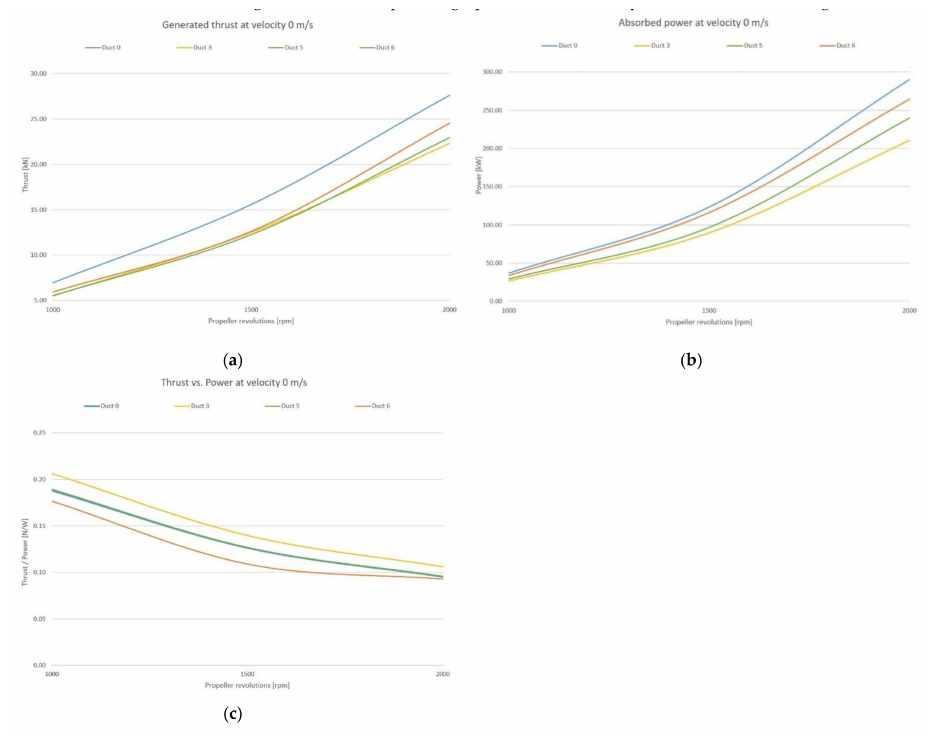
Figure 7. Comparison of parameters for flow velocity 0 m/s. ( a ) Generated thrust at velocity 0 m/s; ( b ) absorbed power at velocity 0 m/s; ( c ) generated thrust per unit of absorbed power at the speed of 0 m/s.